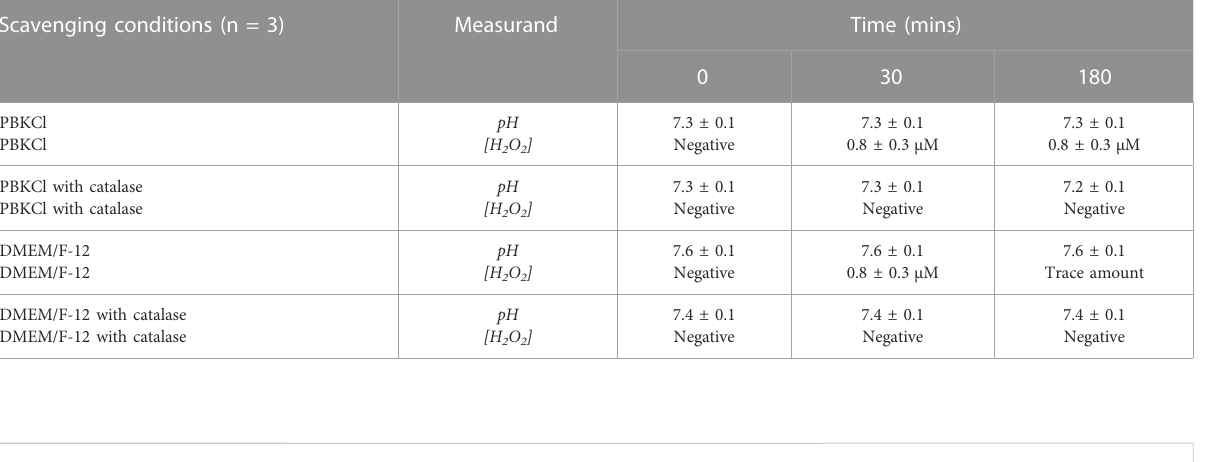
TABLE 3 pH and H 2 O 2 concentration under eLOS oxygen scavenging.